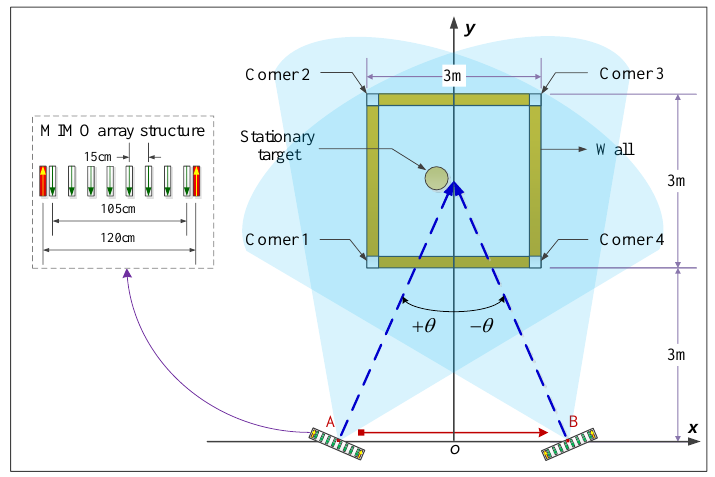
Figure 3. Single-side two-location spotlight imaging model in the CST